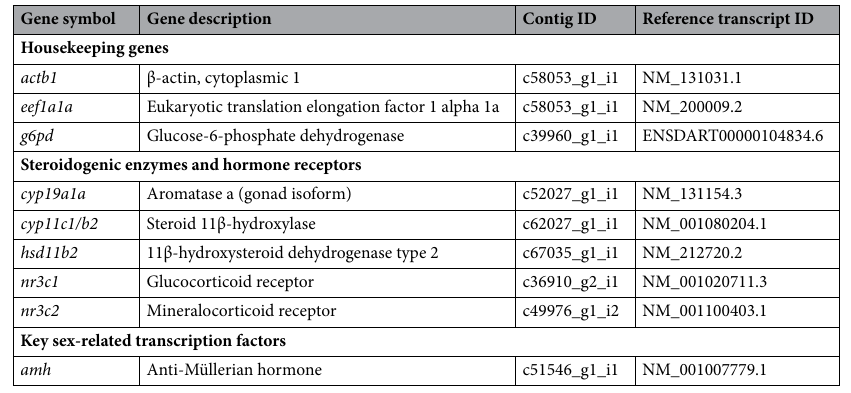
Table 2. Genes analysed in spotty wrasse gonad using the nanoString nCounter™ CodeSet